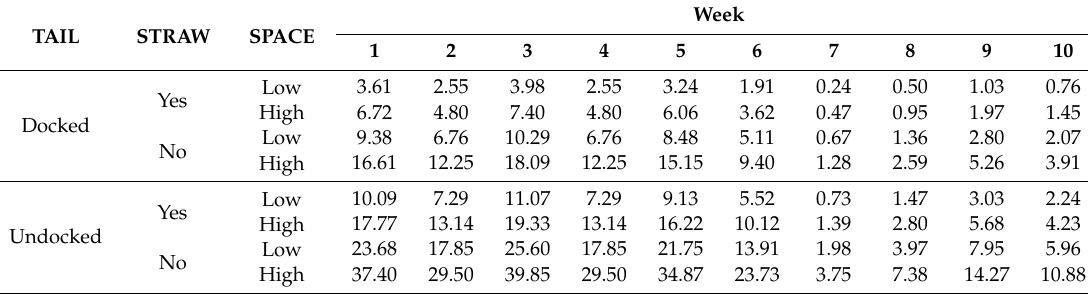
Table 2. The probability of a tail biting event for each combination of the three treatments (TAIL, STRAW and SPACE) in each week of the study